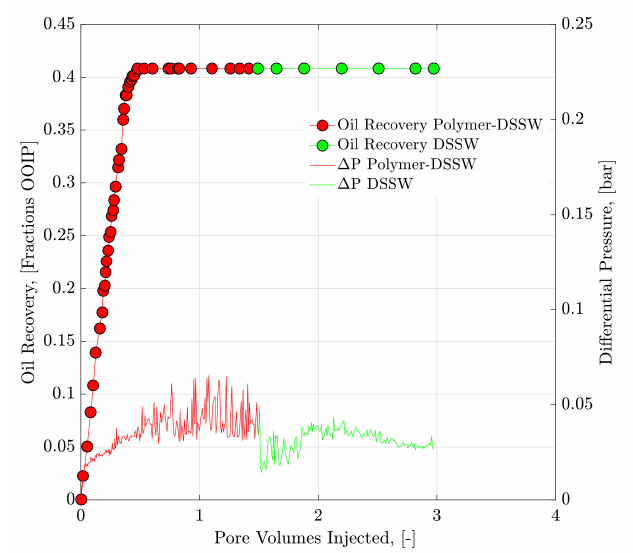
Figure 10. Oil recovery and pressure drop versus pore volume ( PV ) injected for Bent 5.1 core plug. Red represents the experimental data for secondary mode injection of polymer-DSSW, while green is for the tertiary injection mode of